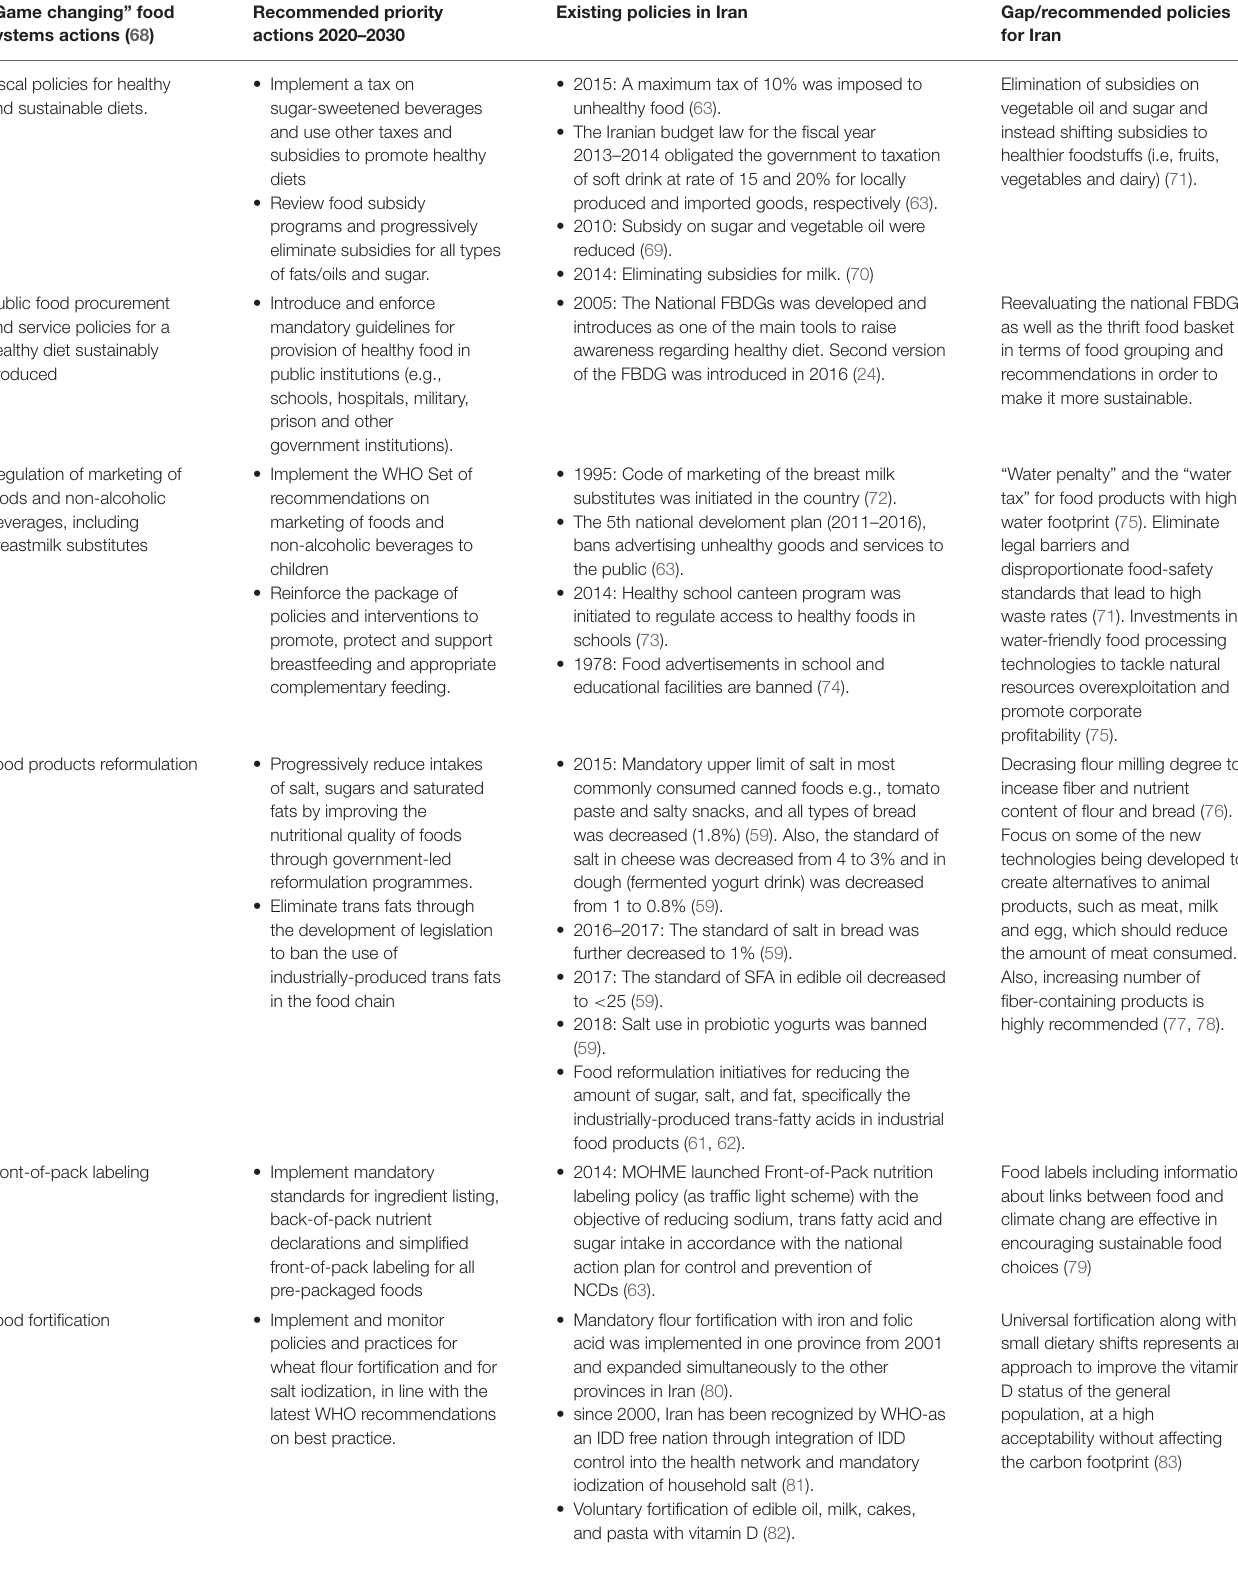
TABLE 2 | Regional recommended strategies for a sustainable food diet, current status of related policies in Iran, and recommended